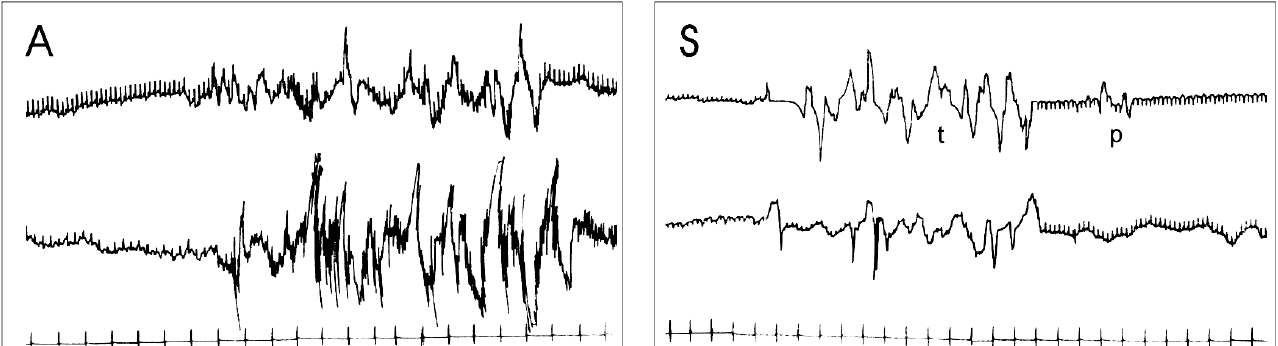
FIGURE 2 - Electromyographic and electrocardiographic recordings in neonatal rats. A: waking period with gross body movement; S: sleep period with atonia and phasic (p) and tonic (t) movements. Cal. 1 sec – 50 microV